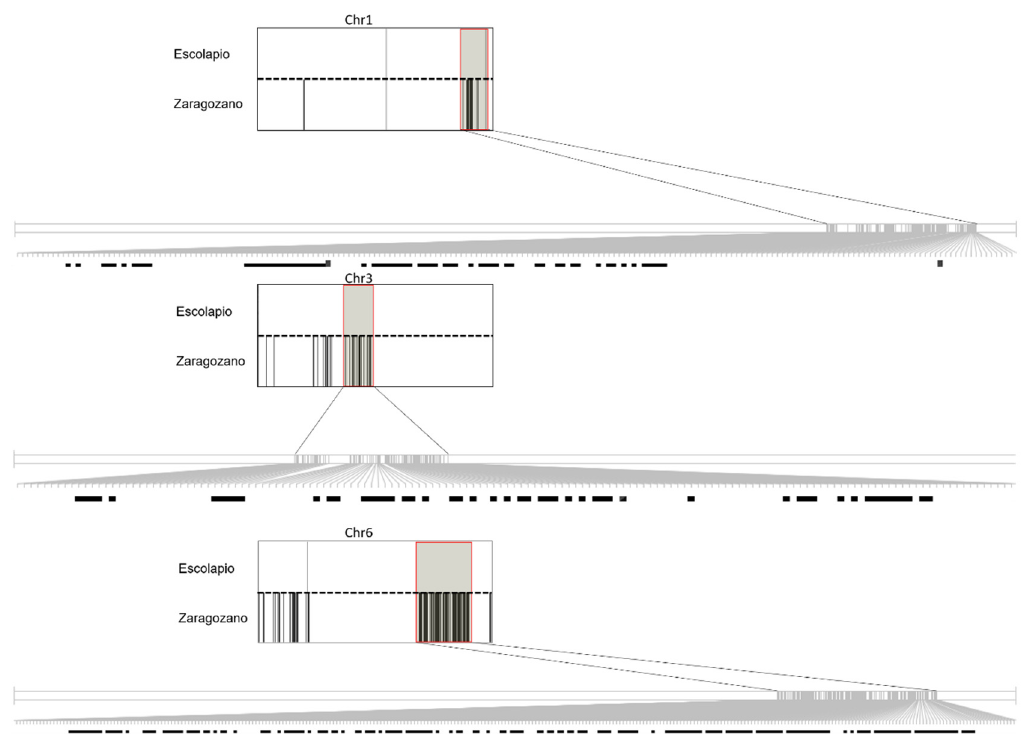
Figure 1. Representation of genotype differences found in chromosomes 1, 3, and 6 between ‘Escolapio’ and ‘Zaragozano’ accessions represented by Flapjack software [43]. The rectangle represents whole chromosomes of both accessions, separated by dotted lines. A black line means that a different genotype was observed between both accessions, while white means the same genotype. Regions with high genotype differences were zoomed in and highlighted by a red rectangle.